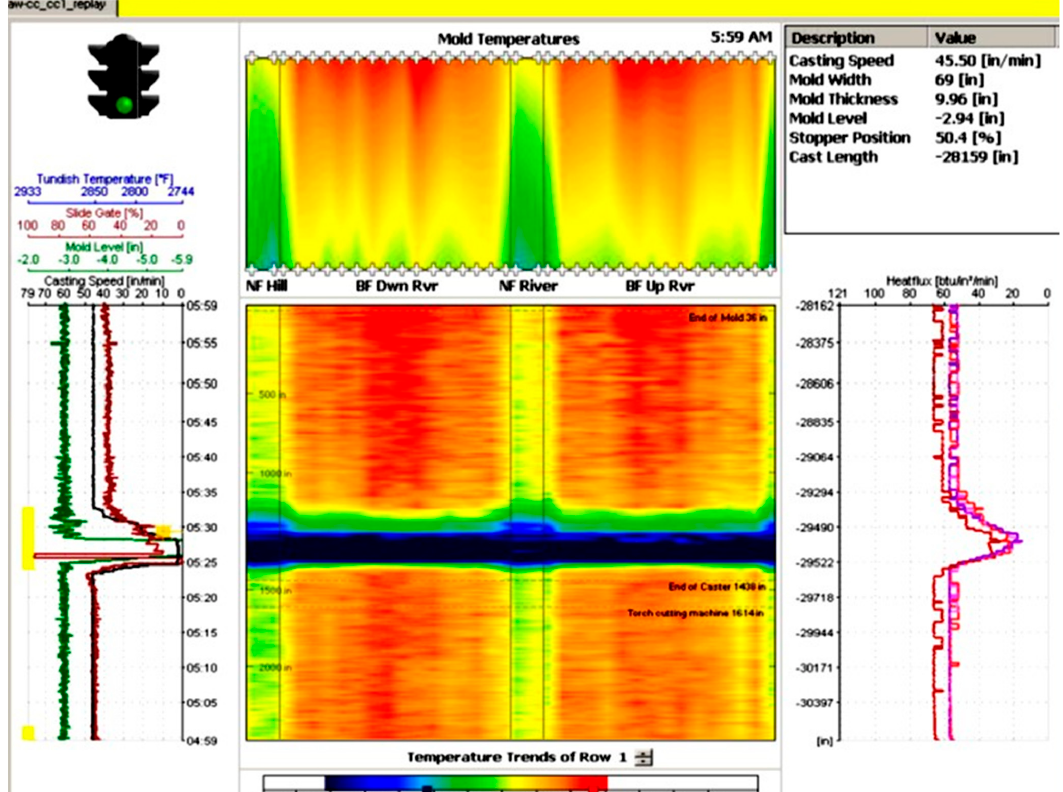
Figure 9. Entire conditions of the casting process inside the mold.